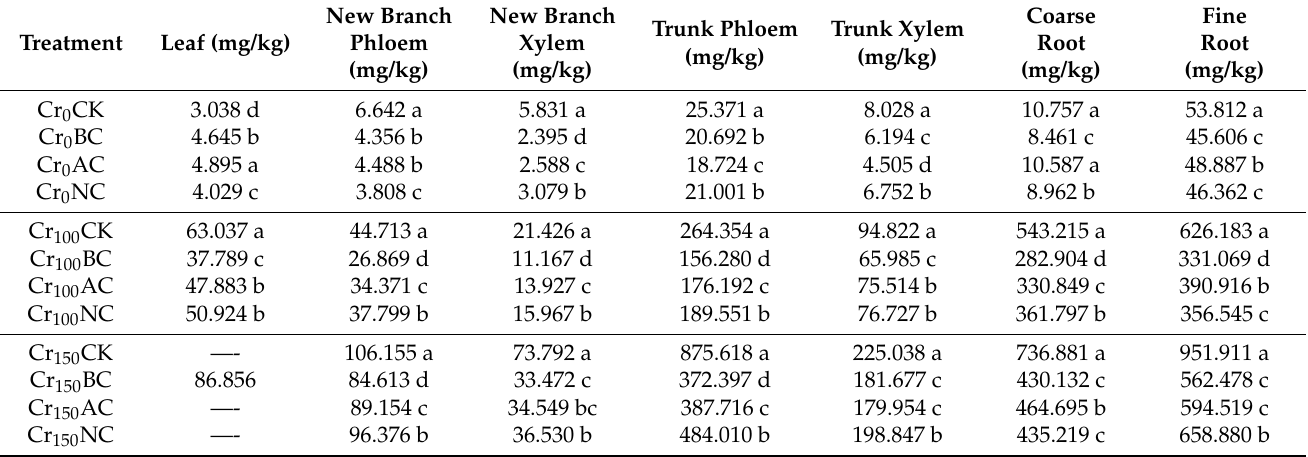
Figure 3. The effect of BC, AC, and NC application on the dry weight and total Cr content of peach trees under Cr stress. ( A ). The dry weight of shoots. ( B ). The dry weight of roots. ( C ). Cr accumulation in peach trees. Data represent the means of three replicates ± SEs, and different letters indicate significant differences ( p < 0.05). Table 4. Effects of BC, AC, and NC application on the concentration of Cr in peach trees under Cr stress.